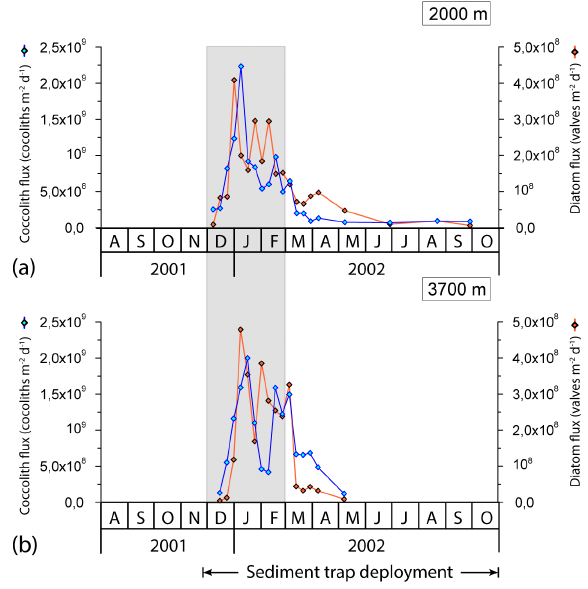
Figure 5. Seasonal variation in total coccolith and diatom valve flux at the 2000 and 3700m sediment traps at the 61 ◦ S site. Grey strips represent